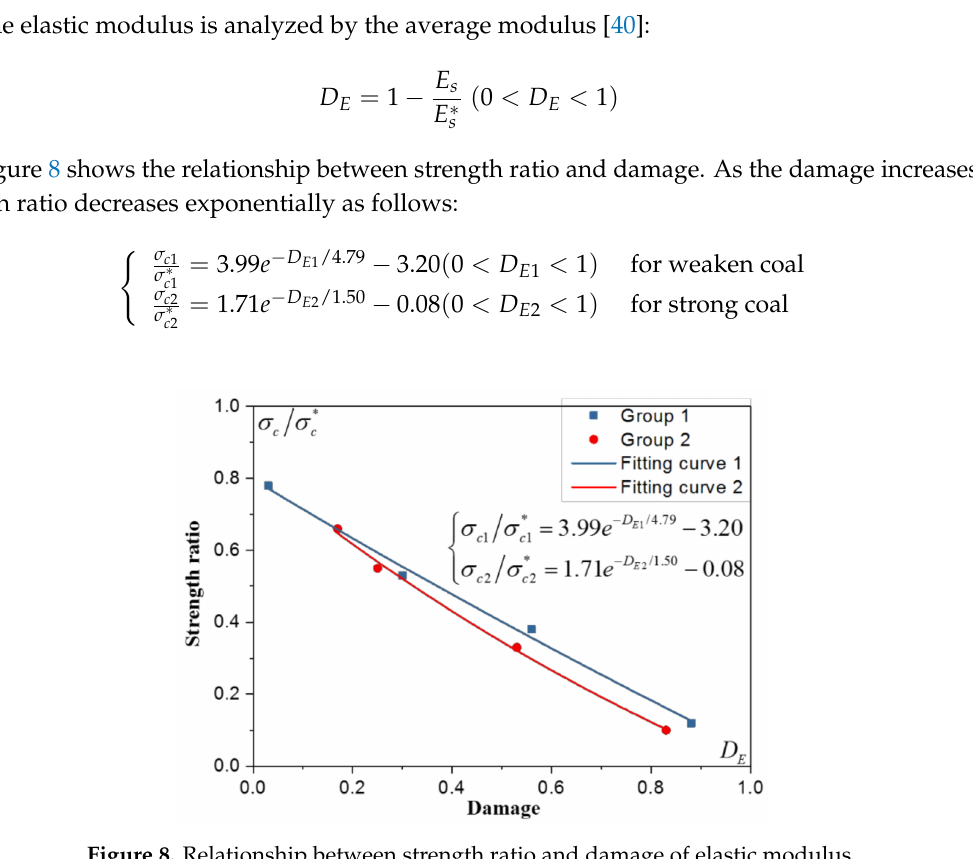
Figure 8. Relationship between strength ratio and damage of elastic